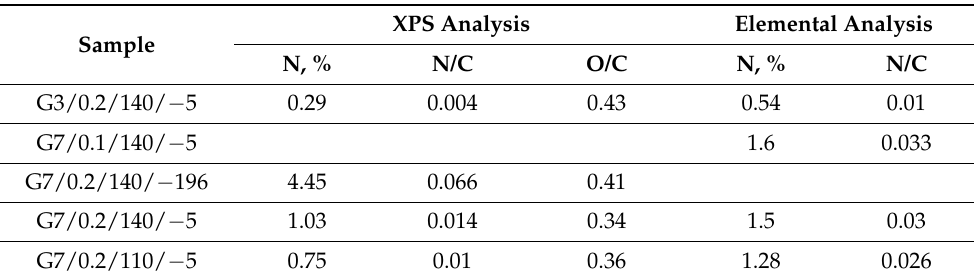
Table 1. Chemical composition wt.% by XPS measurements and elemental analysis. (sample notation: